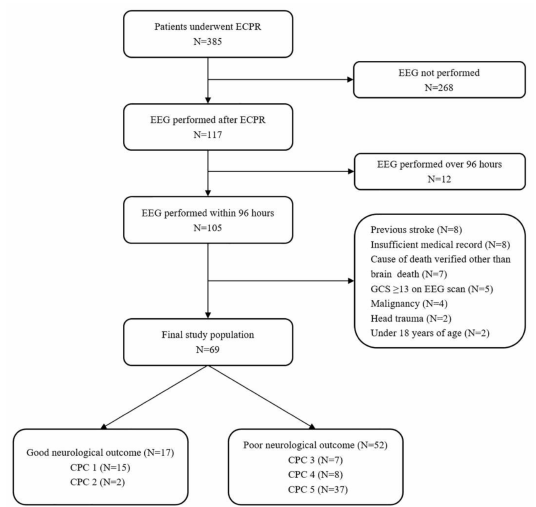
Figure1. Studyflowchart. ECPR,extracorporealcardiopulmonaryresuscitation;EEG,electroencephalography; GCS, Glasgow Coma Scale; CPC, Cerebral Performance